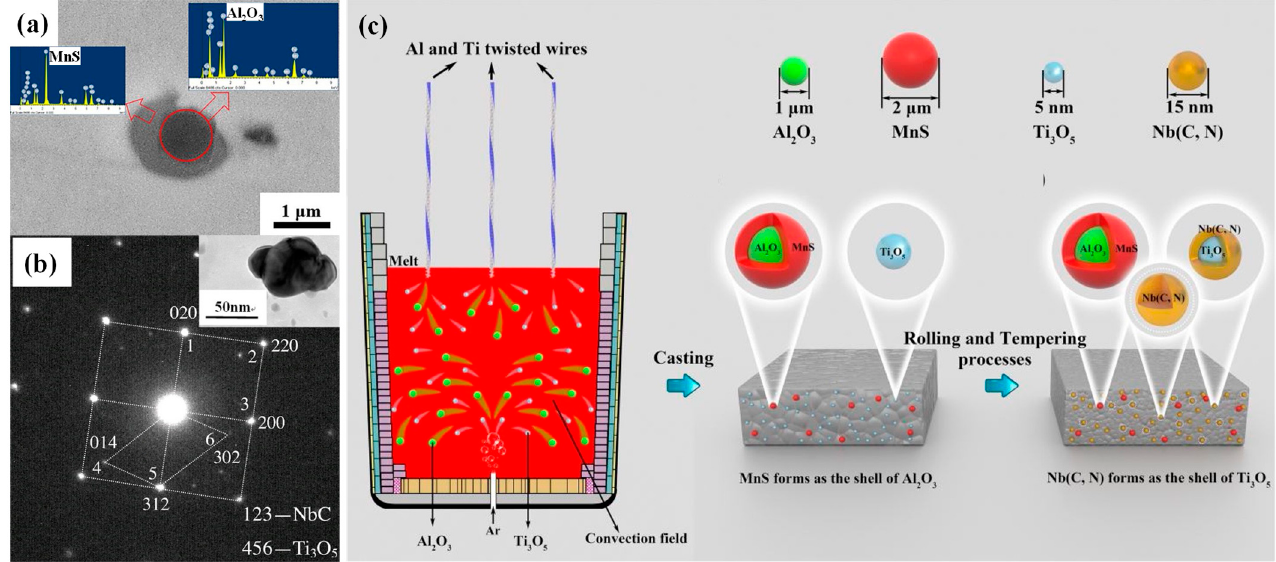
Figure 12. ( a ) SEM morphology of MnS-Al 2 O 3 complex inclusion, reprinted with permission from ref. [10], 2022, Elsevier; ( b ) Index of SADP and TEM morphology of the Ti 3 O 5 -Nb(C,N) core-shell structure, reprinted with permission from ref. [10], 2022, Elsevier; ( c ) Schematic of the trace element multipoint dispersion supply method and the microstructure evolution in casting and tempering process, reprinted with permission from ref. [10], 2022, Elsevier.